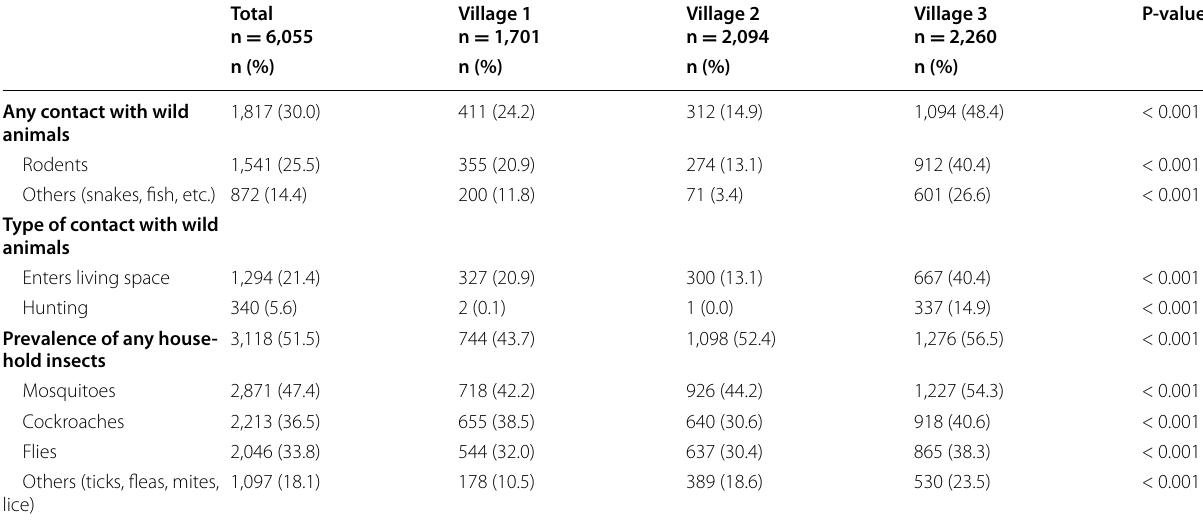
6,055 households) =